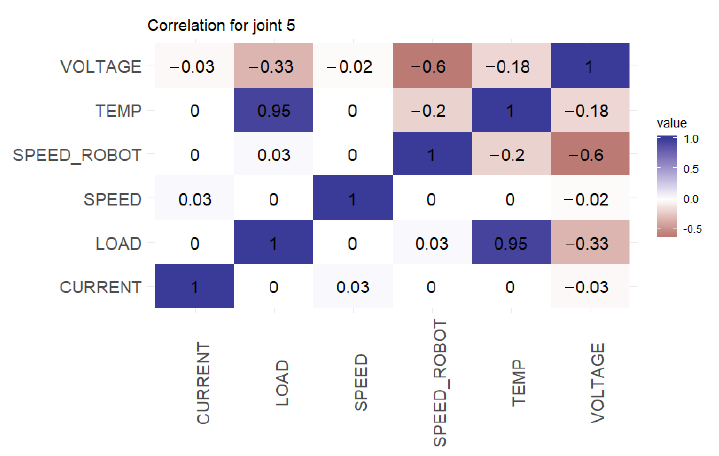
Figure 8. Correlation of joint 4.